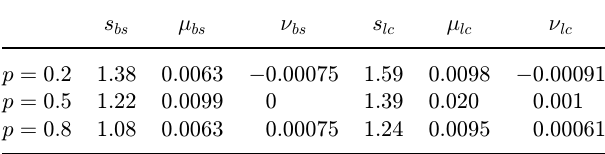
Table 6. Parameters of the distribution of erythrocytes in shape in a shear °ow with the shear rate of 967.0 s (cid:4) 1 , and level of light intensity at the isointensity line equal to 220 (in units of Fig. 6). The normalized light intensity at the isointensity line f ¼ 0 : 035. The number \ p " stands for the proportion of non- 0 deformable red blood cells in a sample of blood. The experiment was performed with the blood of rat